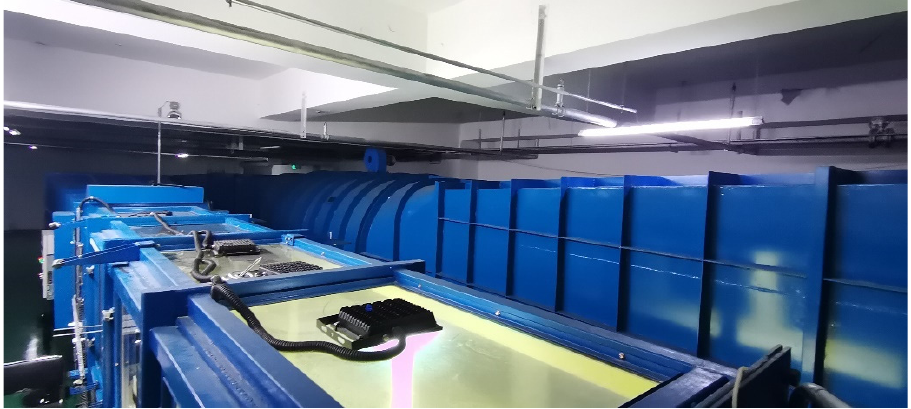
Figure 6. Partial view of wind tunnel.